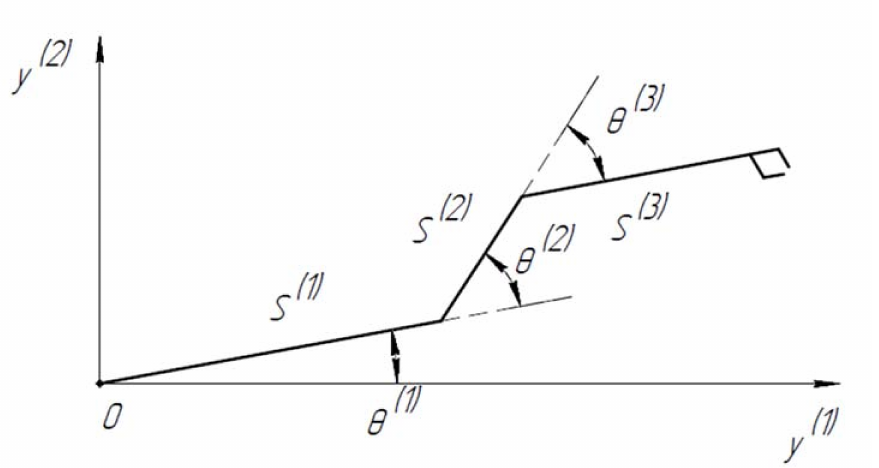
Figure 10. Angles and links defining the configuration of the robotic